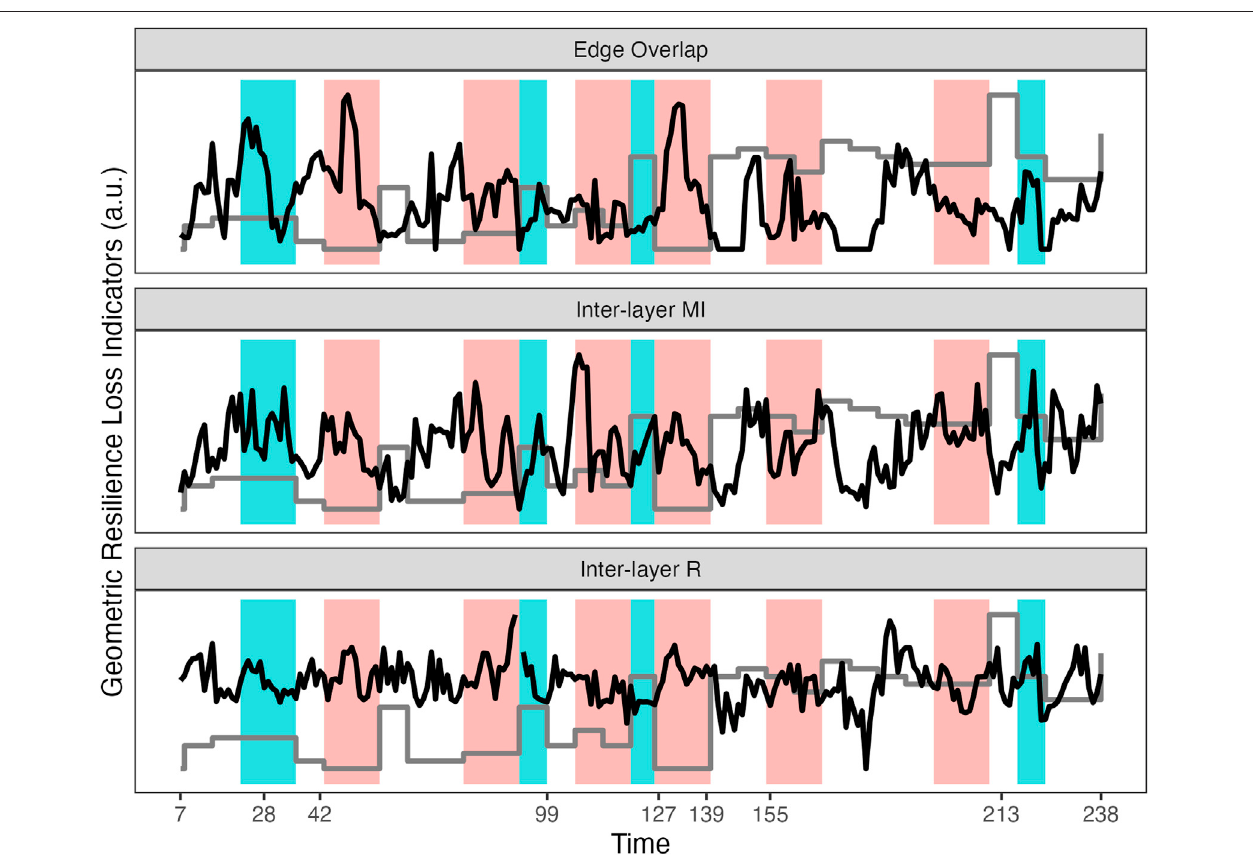
FIGURE 9 | The time course of the Multiplex Recurrence Network measures calculated in a 7 days sliding window: average Edge Overlap, strength-based Inter- layerMutualInformation,strengthbasedInter-layerdegreecorrelationR.Allvaluesaretransformedtotheunitscale.Thegreylinerepresentsthemajorshiftsintheglobal statevariable,thedepressionsymptomscaleSCL-R-90whichwasmeasuredweekly.Thecoloredregionsrepresentasevenor14 dayperiodbeforeanmajorchangein symptom severity.